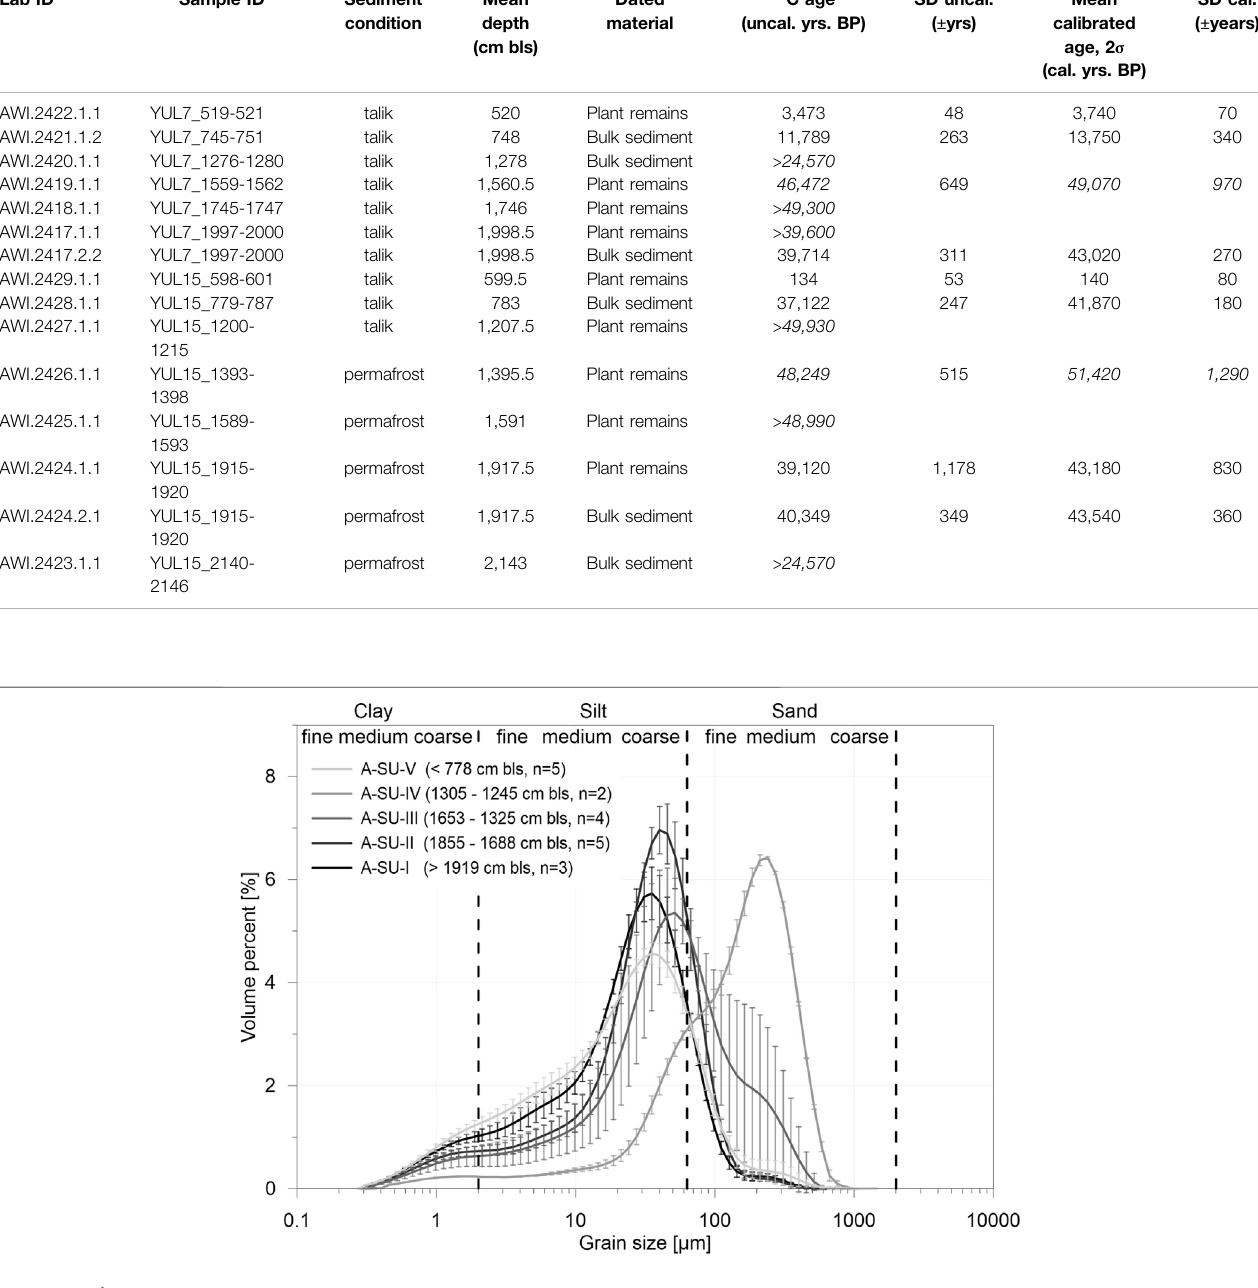
FIGURE 4 | Mean grain-size distributions for each sediment unit of the alas lake core YU-L7 (see also Figure 5 ). The error bars are indicating the standard deviations of individual measured grain sizes.